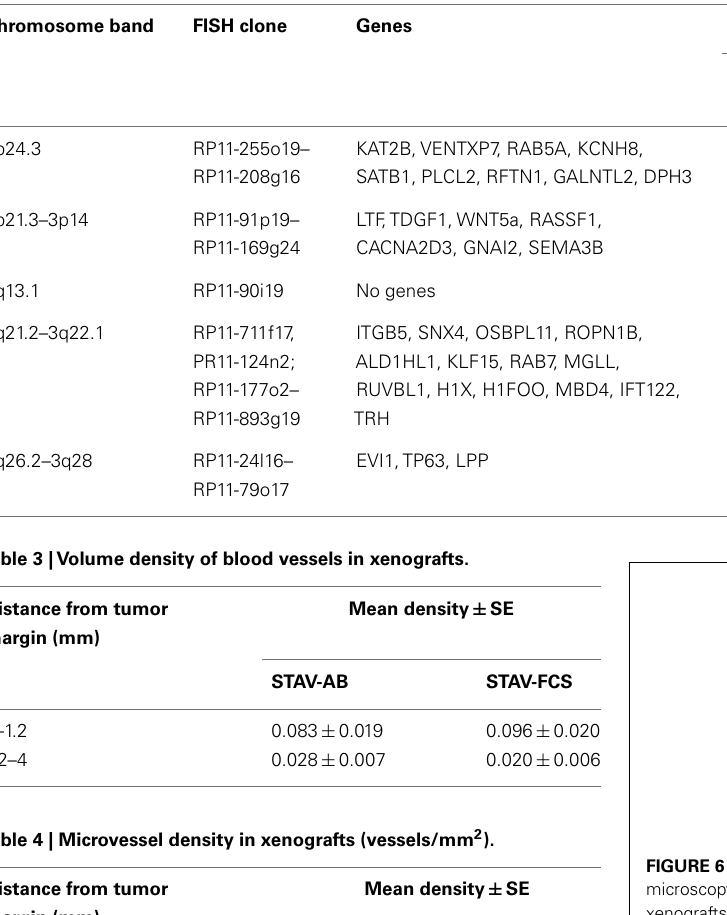
Table 2 | Regions of chromosome 3 and gene locations.